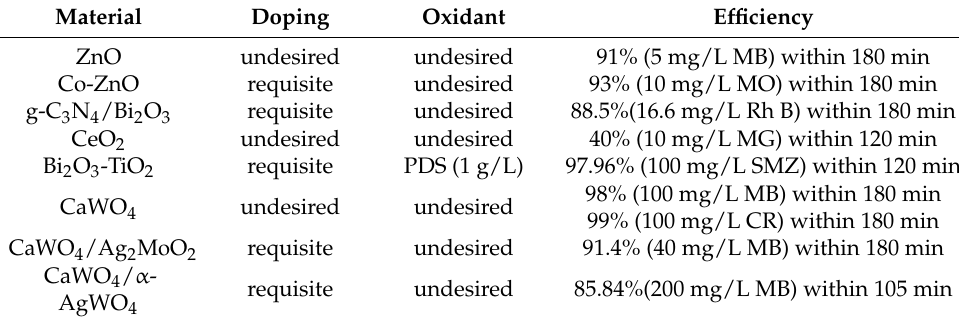
Table 1. Photocatalytic performance of different